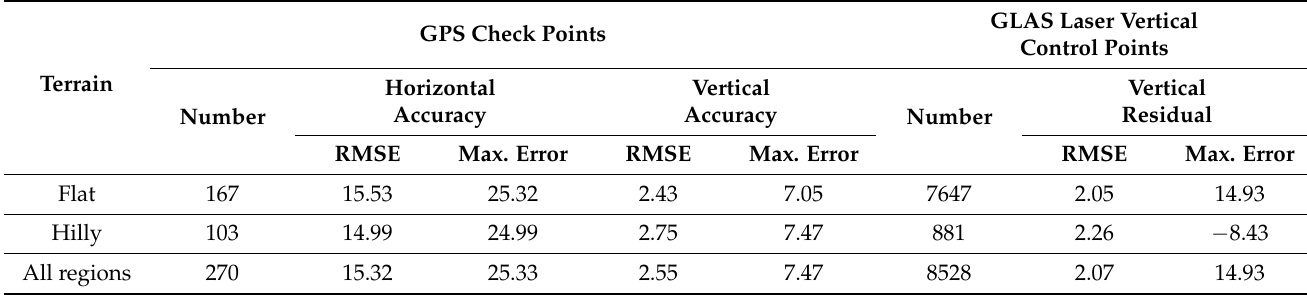
Table 12. Experimental results of integrated processing of ZY3 experimental data (third